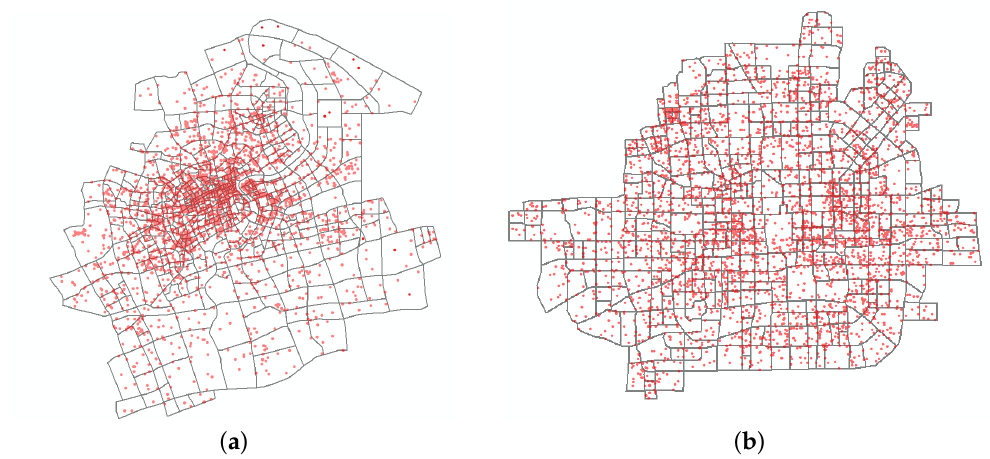
Figure 7. Visualization of road network segmentations in ( a ) Shanghai and ( b ) Beijing. The red dots represent locations of cellular base